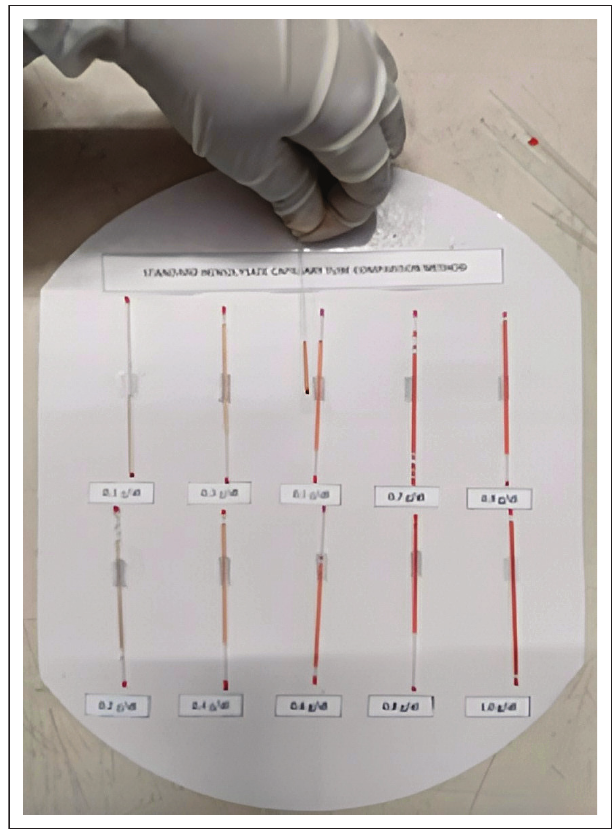
FIGURE 1: Standard haemolysate capillary tube comparison method developed at the Quality Control Department of the National Blood Center, Sri